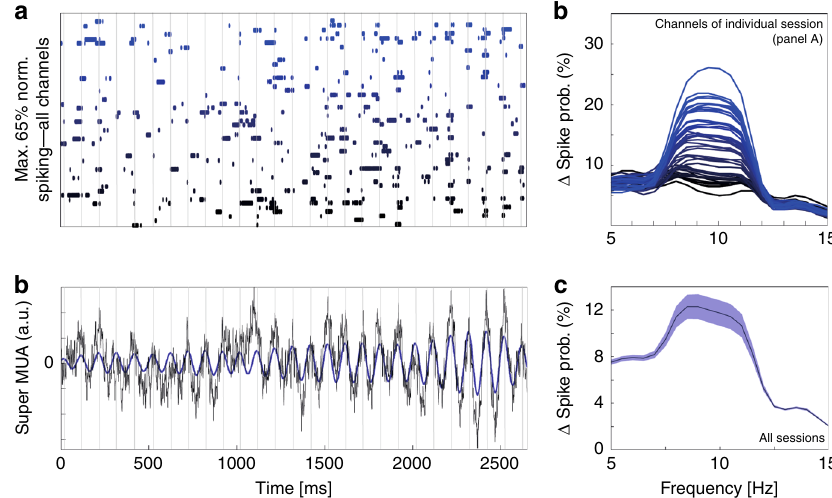
Fig. 3 Alpha rhythm paces FEF population code. a Individual channel spiking probability at a threshold of 65% (1 trial, 48 channels) in time. (Cue is presented at 700 ms. Gray vertical lines: peak of alpha cycles of the super MUA in ( b ). Individual channels ordered and color coded in a gradient of blue, as a function alpha locking amplitude in ( c ). b Raw (black trace) and alpha fi ltered single trial population super MUA calculated over the 48 MUA channels (blue trace). Gray vertical lines: peak of alpha cycles of the super MUA. c Changes in individual channel spiking probability, across all trials, as a function of putative locking to frequencies from 5 to 15 Hz. Spiking probability is speci fi cally affected in the alpha frequency. Channels color coded in a gradient of blue, as a function of alpha locking amplitude. d Mean + / − s.e. phase frequency modulation of spiking activity across all sessions and all channels.